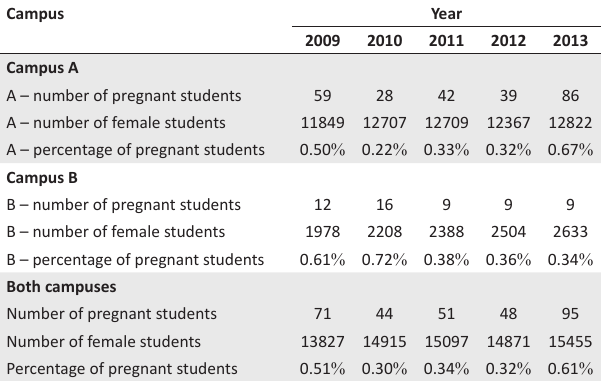
TABLE 1: The unplanned pregnancy rate from 2009 to 2013 at the selected higher educational